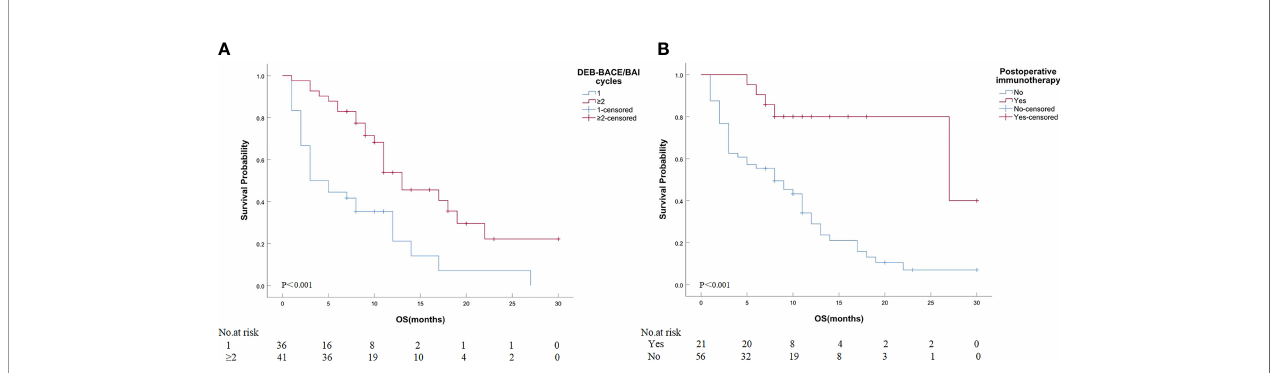
FIGURE 4 | Kaplan – Meier analyses of OS in ASTRI-NSCLC treated with DEB-BACE. (A) The estimated median OS was 3.0 months for patients treated with one cycle of DEB-BACE compared with 13.0 months for those patients with no less than two cycles of DEB-BACE/BAI. (B) The estimated median OS was 27.0 months for patients with postoperative immunotherapy compared with 8.0 months for those patients without. OS, overall survival; ASTRI-NSCLC, advanced standard treatment-refractory/ineligible non-small cell lung cancer; DEB-BACE, drug-eluting bead bronchial artery chemoembolization; BAI, bronchial artery infusion